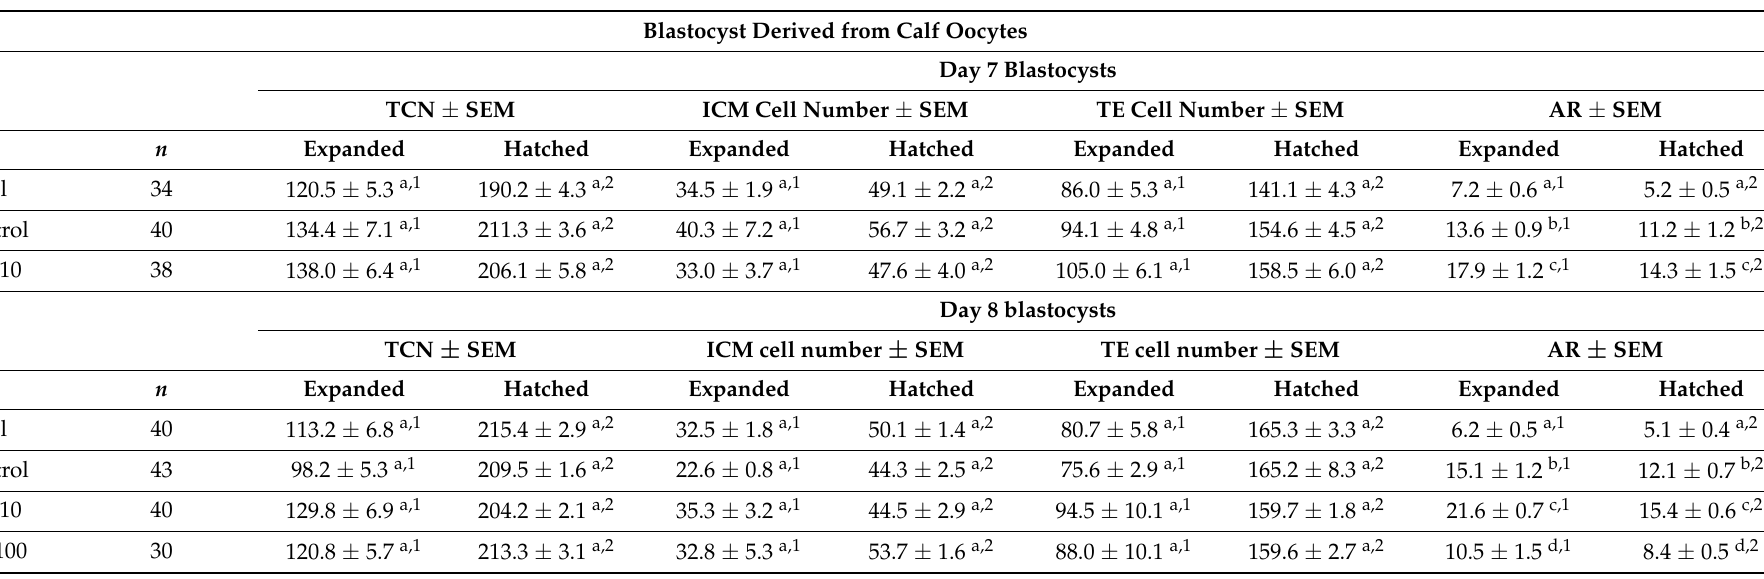
Table 4. Total cell number; n ◦ of cells in the ICM and TE; and rate of apoptotic cells of surviving expanded and hatched blastocyst produced from calf-derived blastocysts vitrified/warmed using VIT-Control, VIT-EPS10, and VIT-EPS100 treatments.